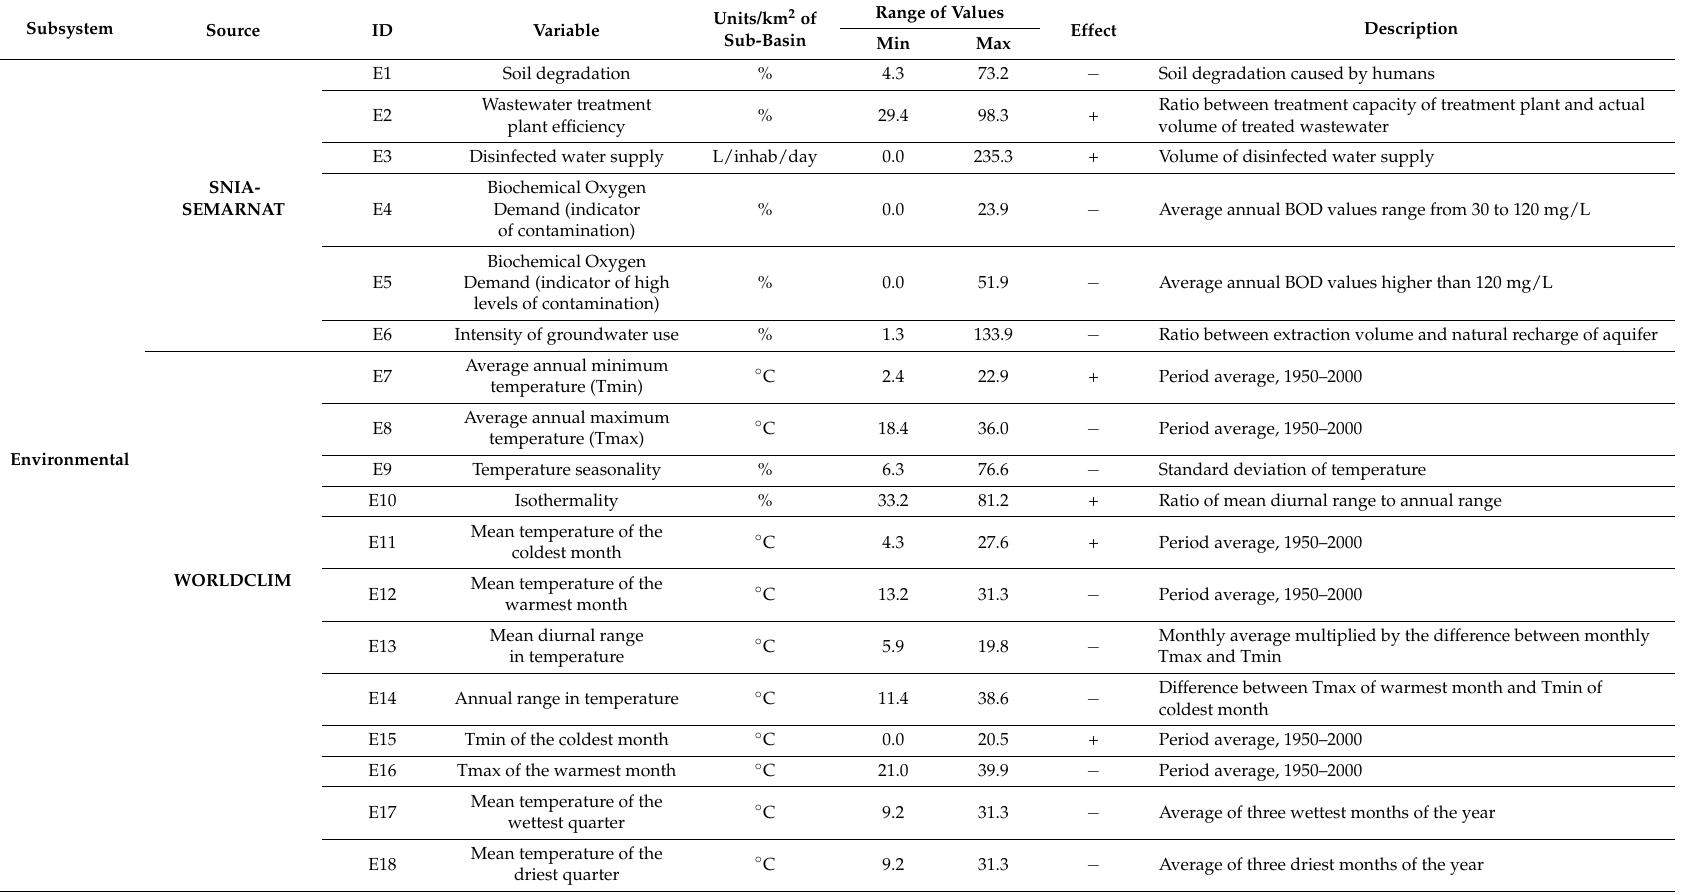
Table B1. Variables used for regionalization of urban sub-basins. Beneficial (+) or harmful ( − ) effect on water resources